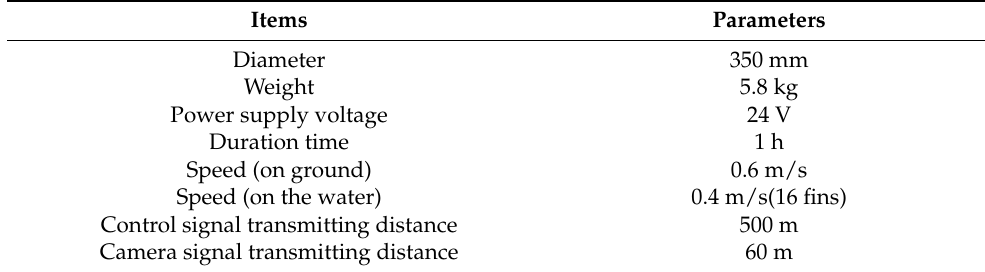
Table 1. Specifications of the amphibious spherical